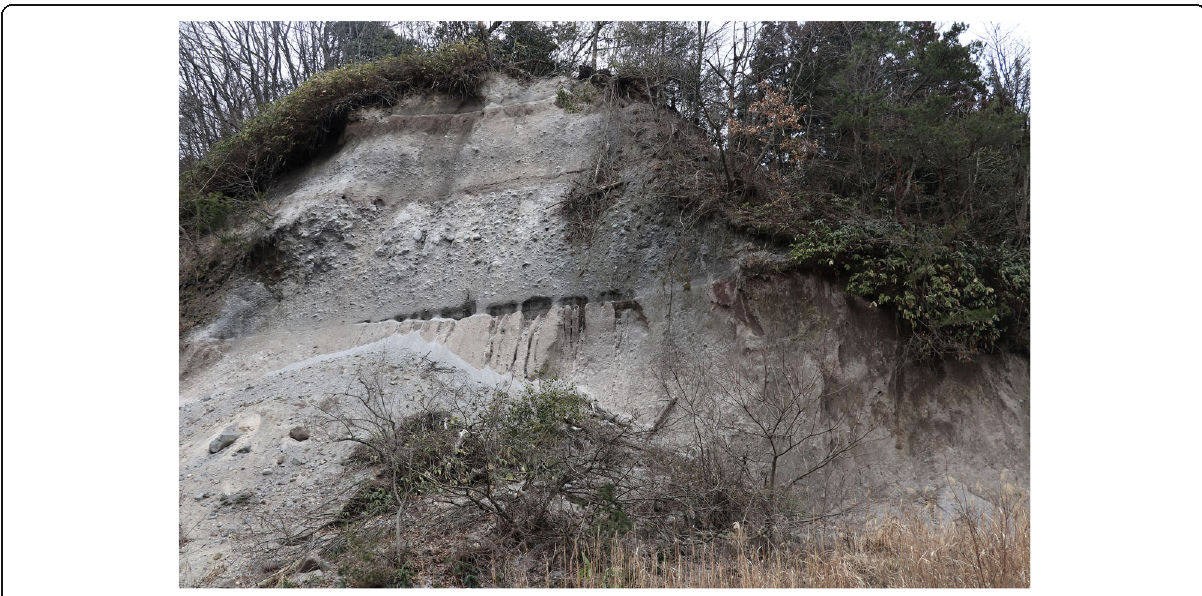
Fig. 18 Several flow units from the Taiheizan block and ash flow form Sanbe volcano, exposed by a recent landslide. Contemporary ash fall deposits can be seen in Fig. 16 (lower image, uppermost unit). The deposit is located approximately 2.5 km south from the presumed locality of the active lava dome and has been originally emplaced with a valley fill areal distribution, but now remains only as isolated bars in the several valleys around the